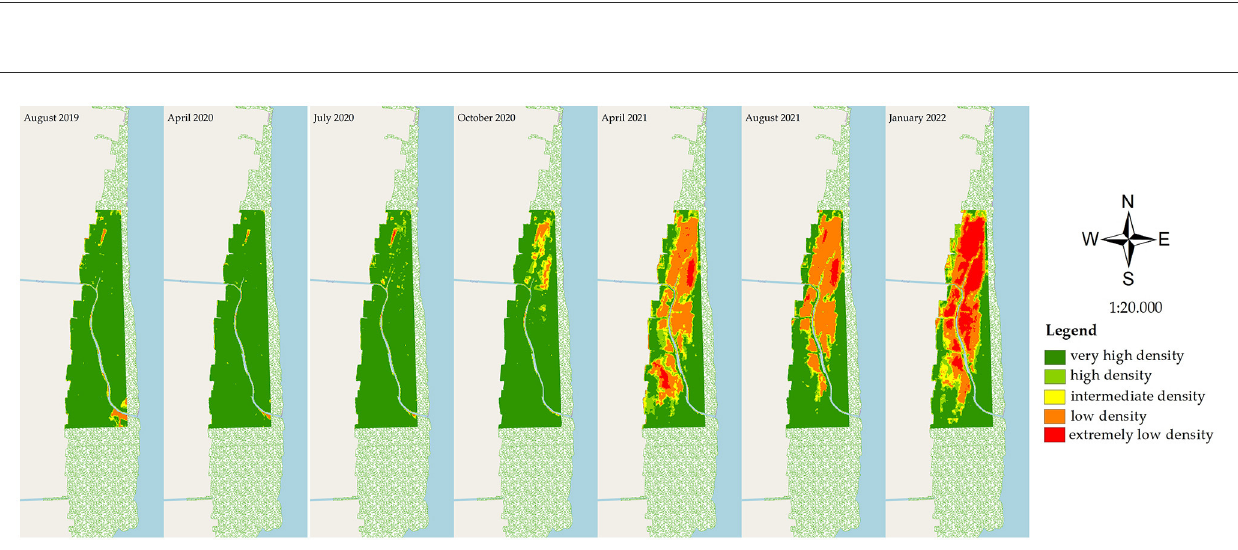
FIGURE5 Results from NDVI analysis of the mangrove condition in East Lampung, Sumatra, in different months in August 2019–January 2022 (map base: ESRI OpenStreetMap by ArcMap 10.8, accessed on March 12, 2022).